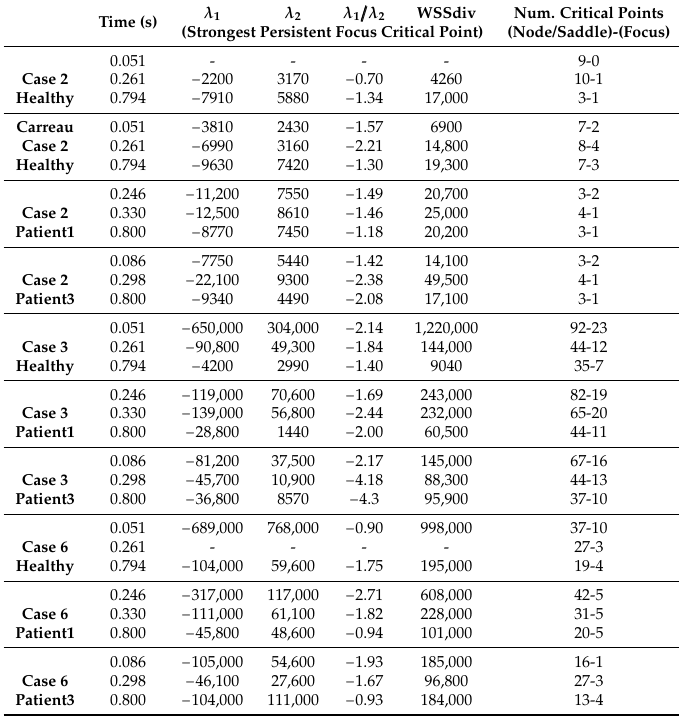
Table A1. Continuation of Table 2, for Case 2, Case 3 and Case 6 with flow rate profiles shown in Figure